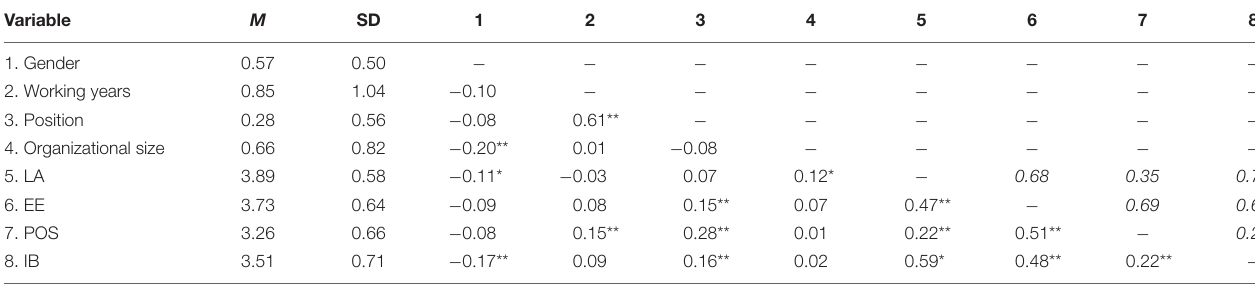
TABLE 1 | Descriptive statistics, correlation, and heterotrait-monotrait (HTMT) matrix among study variables. Variable M SD